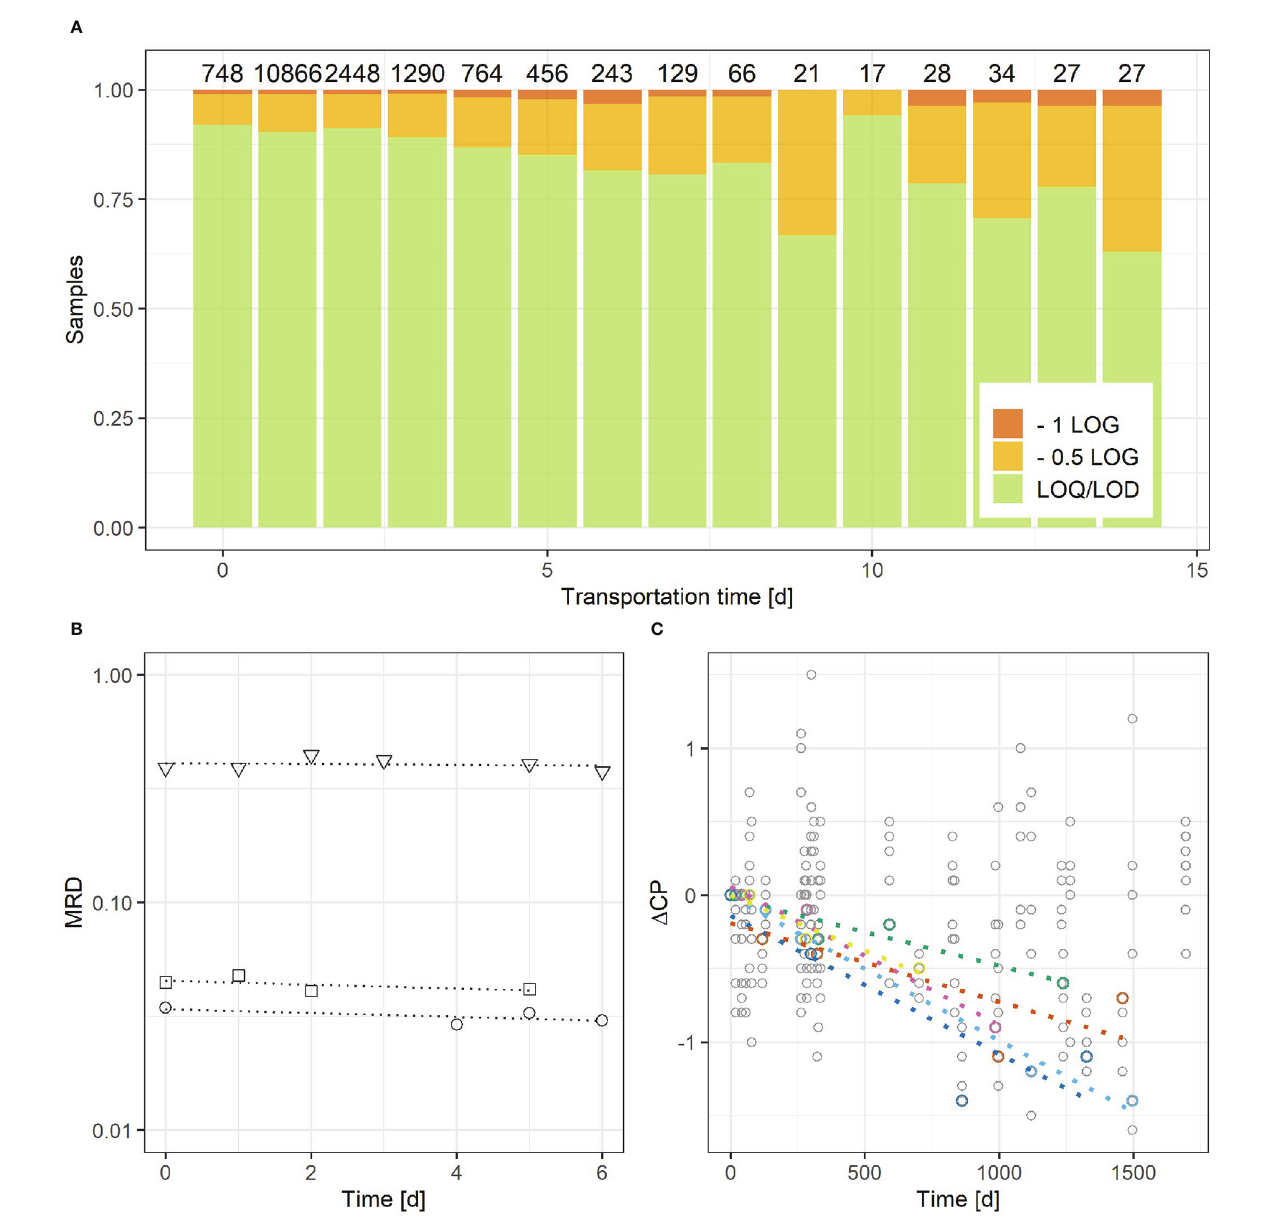
FIGURE 3 Assessment of short-term stability of medical samples (A, B) and long-term stability of reagents (C) . (A) Short-term stability was evaluated based on the need to adapt the analytic sensitivity of an MRD assessment due to a lower number of cell equivalents per ng of DNA in a test. If ≥ 50% of the required cell equivalents could be tested no adaptation of analytic performance was required (LOQ/LOD, green). LOQ and LOD is reduced by 1 LOG or 0.5 LOG level if <10% or <50% of the required cells would be tested, respectively. Cell equivalents were calculated from the copy number of the albumin gene determined by RQ-PCR according to (9). (B) PB was used to evaluate the potential drift of the MRD value from 3 CLL samples up to 6 days ambient storage after sample collection to prospectively assess short-term stability of medical samples. (C) Long-term stability was assessed from the Cp signal drift of a total of 60 primer and standard combinations from 10 CLL assays and during time periods of up to 4 years (only standards with signi fi cant Cp- drift are